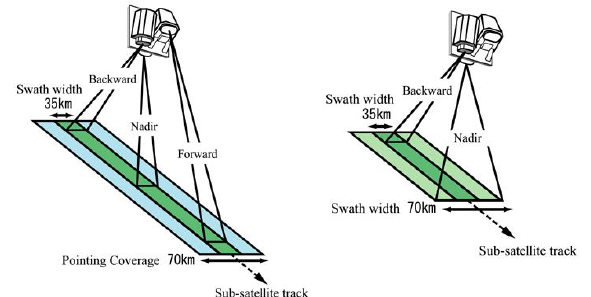
Figure 1. Observation geometries of PRISM triplet observing mode (OB1, left), and stereo (by nadir plus backward) observing mode (OB2, right) .